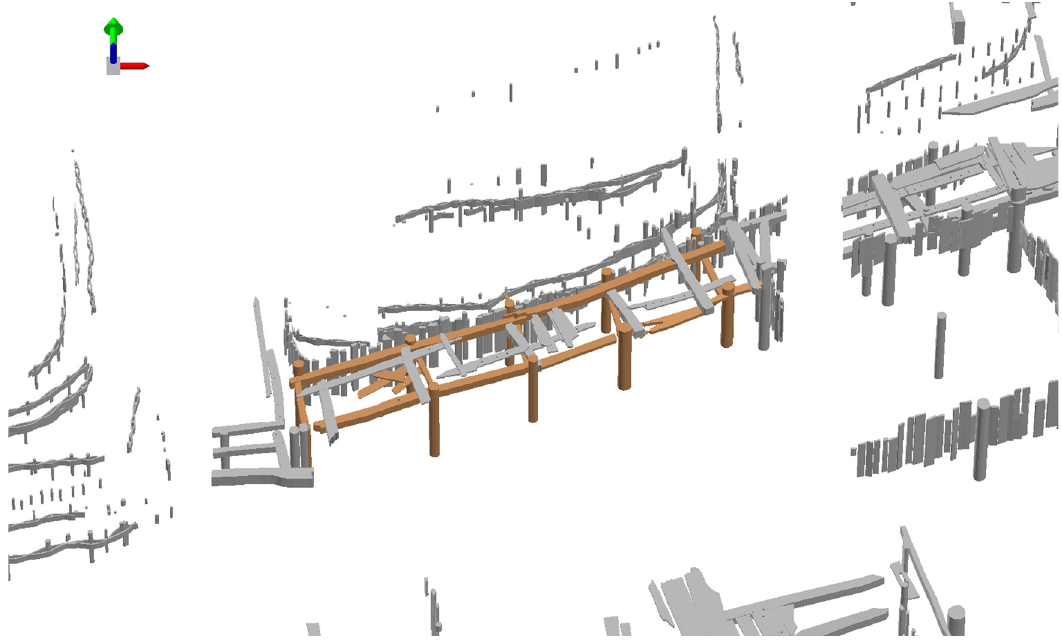
Figure 10: Executing step 13: extract of a 3D visualization of wood groups. A structure consisting of several groups, the fi rst phase of a corduroy street, is highlighted in brown ( Graphics: F. Rösch )